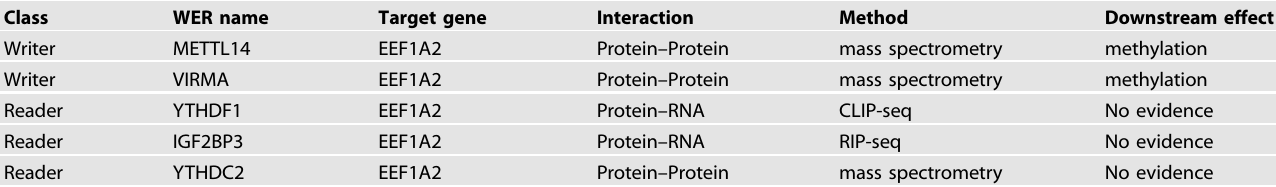
Table 1. Binding result of searching EEF1A2 on m6A2Target